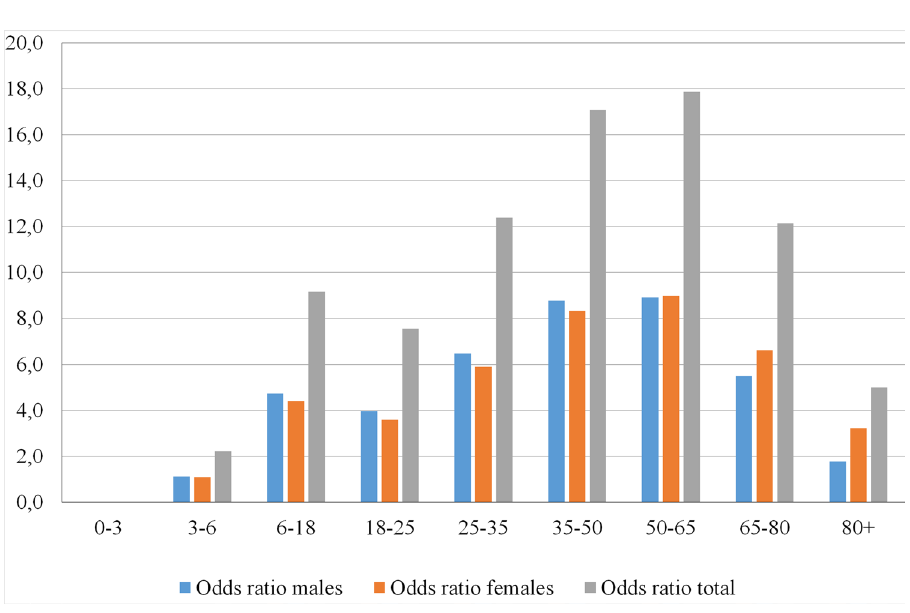
Figure 4. Presentation of the odds ratio in different gender and age